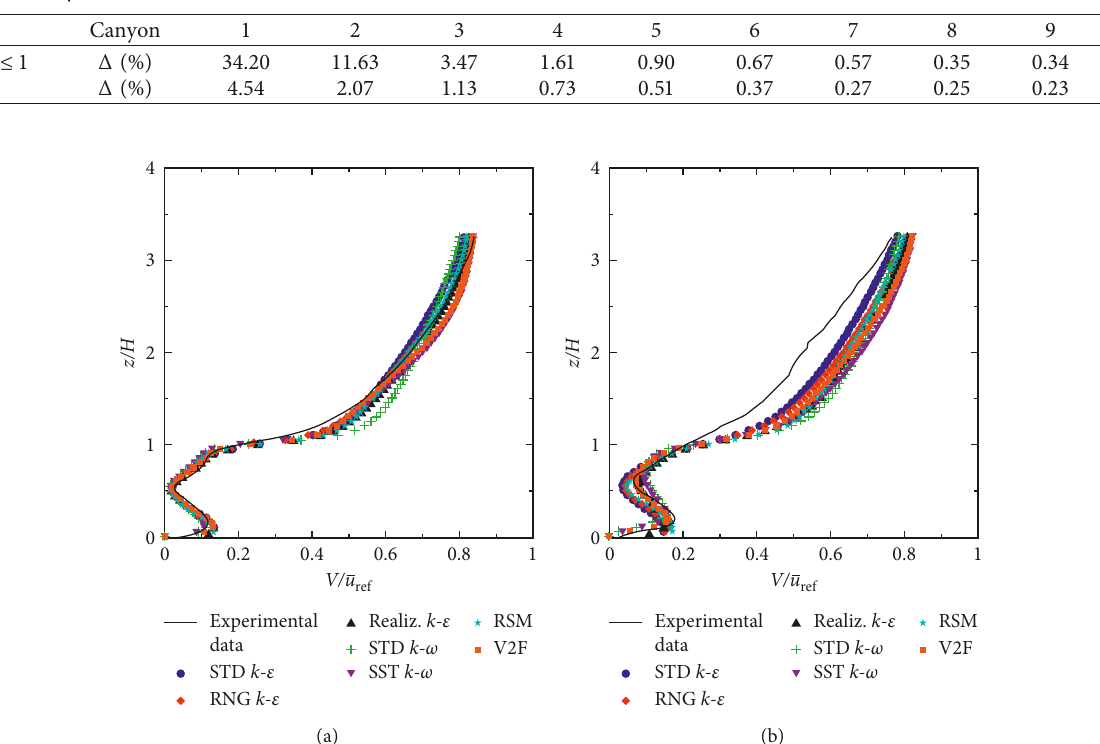
Figure 7: Comparison between simulated (symbols) and measured (line) vertical profiles of V/u for AR 1 (a) and AR 0.5 (b). (cid:31) (cid:31)